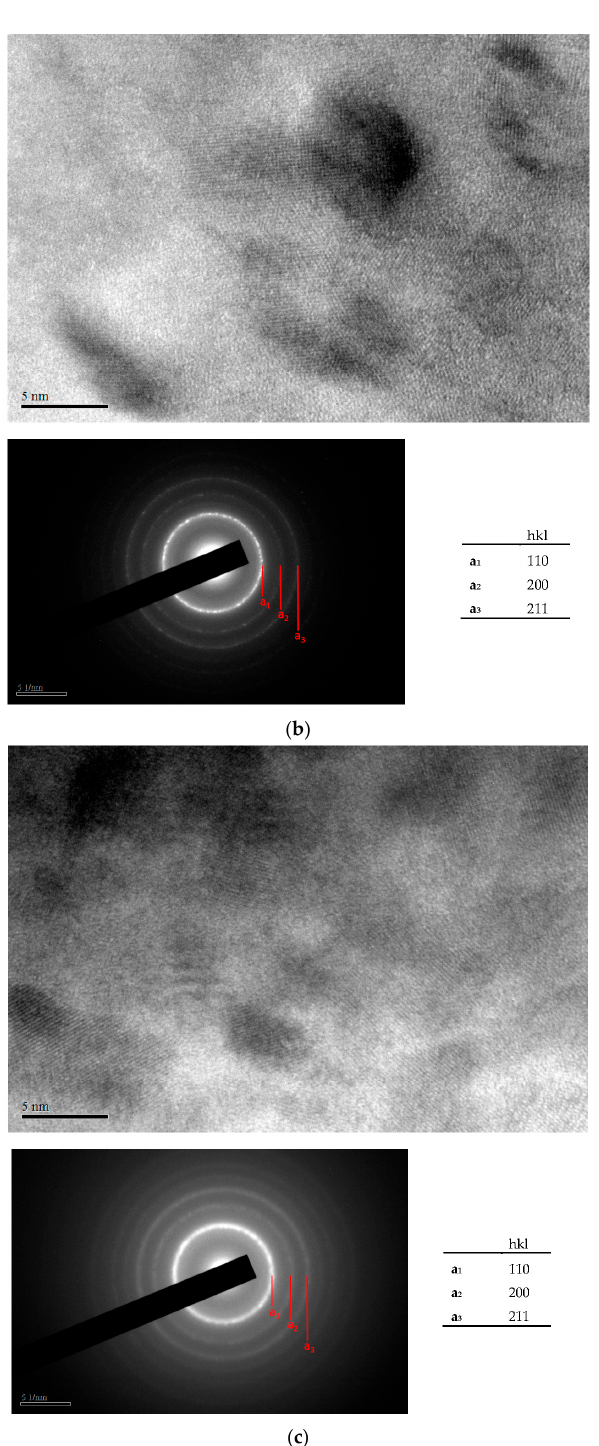
Figure 5. ( a ) TEM micrograph and electron diffraction pattern of anneal-hardened Fe-Cr-C alloy deposit prepared with 20 ASD. The deposit was RTA-treated at 500 ◦ C for 10 s. The diffraced planes a 1 , a 2 and a 3 correspond to (110), (200) and (211) planes of Fe with body-centered cubic structure; ( b ) TEM micrograph and electron diffraction pattern of anneal-hardened Fe-Cr-C alloy deposit prepared with 25 ASD. The deposit was RTA-treated at 500 ◦ C for 10 s. The diffraced planes a 1 , a 2 and a 3 correspond to (110), (200) and (211) planes of Fe or Cr with body-centered cubic structure; ( c ) TEM micrograph and electron diffraction pattern of anneal-hardened Cr-Fe-C alloy deposit prepared with 30 ASD. The deposit was RTA-treated at 500 ◦ C for 10 s. The diffraced planes a 1 , a 2 and a 3 correspond to (110), (200) and (211) planes of Fe or Cr with body-centered cubic